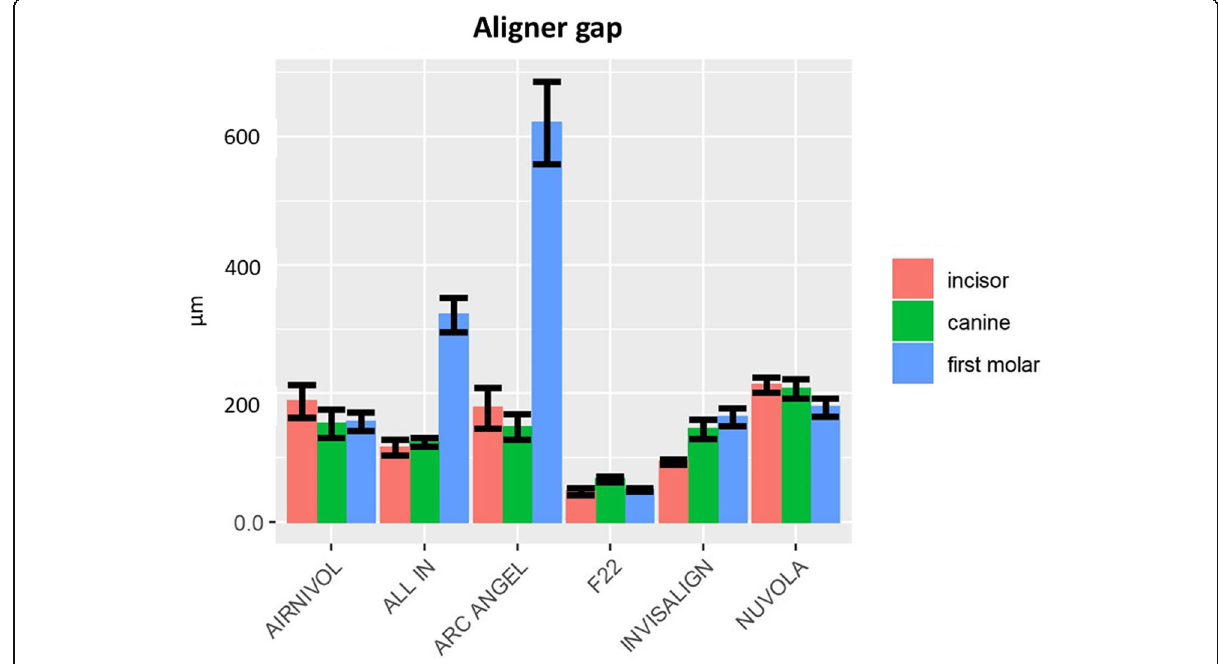
Fig. 7 Graphical representation of aligner gap values and SD